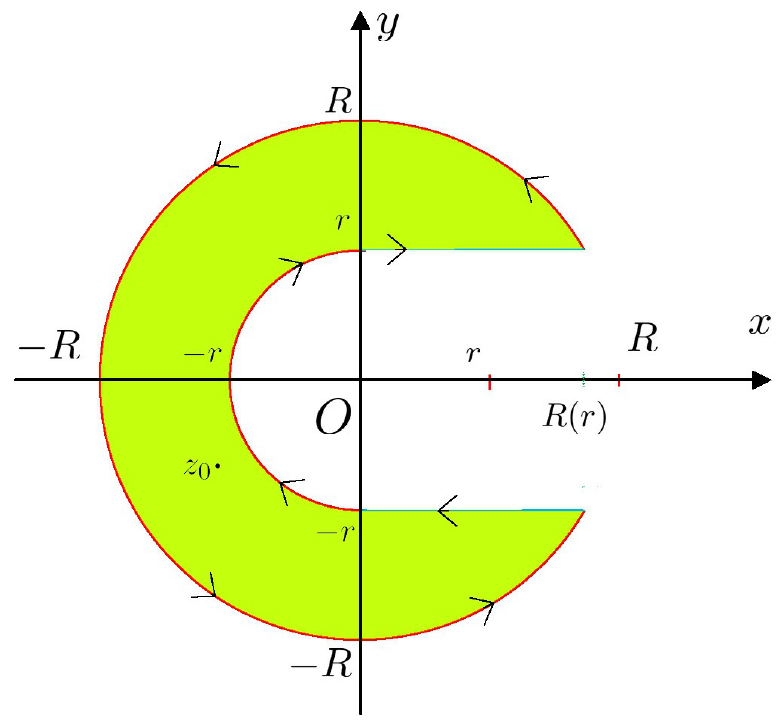
Figure 1. The positively oriented contour L ( r , R ) in C \ [ 0, ∞ )